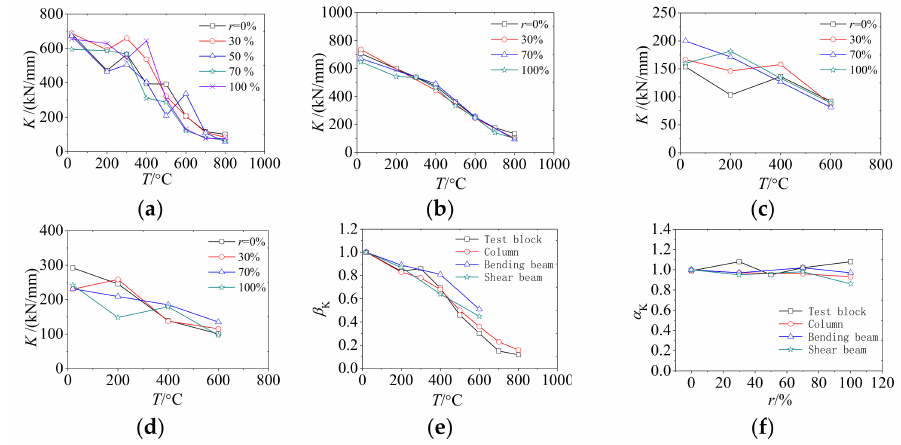
Figure 14. Stiffness degradation. ( a ) rectangular prisms specimens; ( b ) columns; ( c ) bending beams; ( d ) shear beams; ( e ) The influence of temperature; ( f ) The influence of replacement